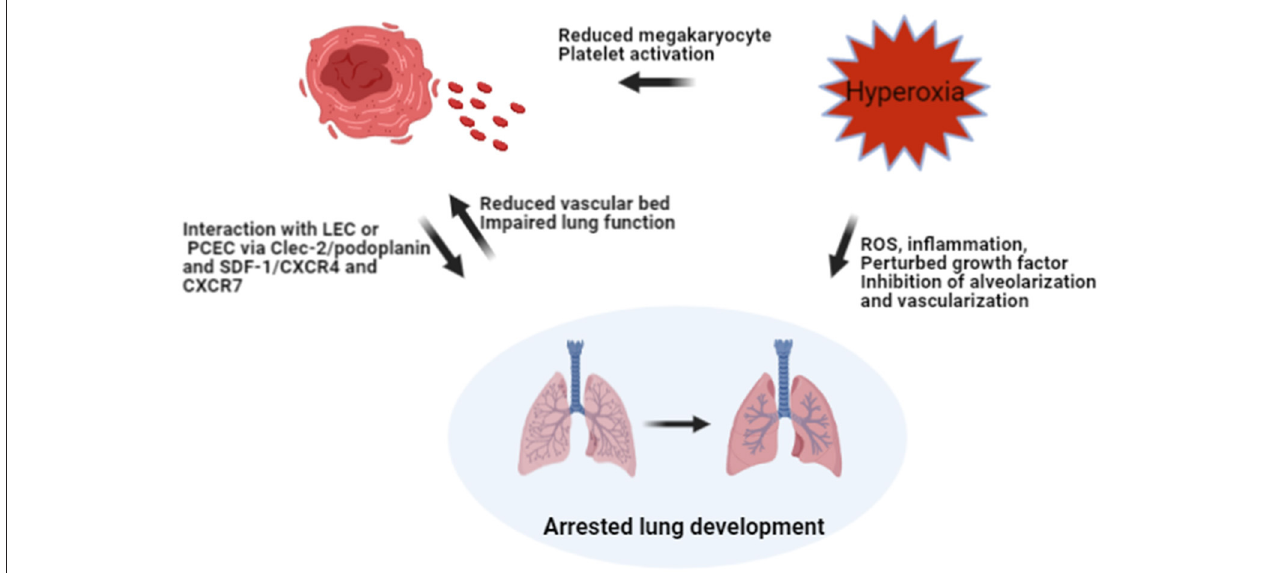
FIGURE 6 | Hypothesis on the interaction between hyperoxia, platelet biogenesis, and lung injury. Hyperoxia may reduce the number of megakaryocytes in the lung and increase platelet consumption by activating platelets, leading to decreased platelet count directly. Hyperoxia may also impair the developing lung by inhibiting alveolarization and vascularization, leading to BPD. The reduction of the vascular bed in BPD, together with impaired lung function might result in reduced shedding of megakaryocytes and pro-platelets trapped in pulmonary capillaries. Meanwhile, reduced PLT may hamper lung development by interacting with LEC and PCEC via ligands and receptors. ROS, reactive oxygen species; LEC, lymphatic endothelial cells; PCEC, pulmonary capillary endothelial cells; Clec-2, C-type lectin-like receptor-2; SDF-1, stromal-cell-derived factor-1; CXCR4 and CXCR7, receptors of SDF-1 on